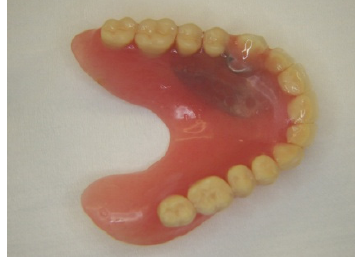
Figure 1. Patient’s existing upper